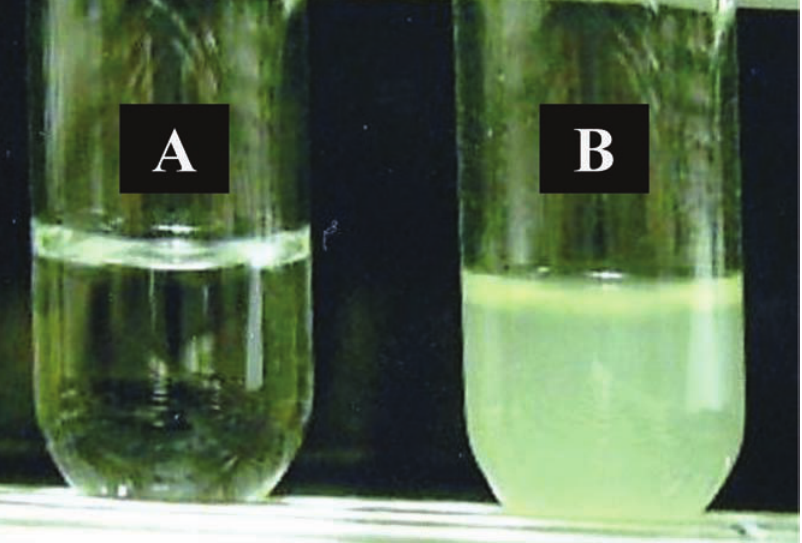
Figure 2. A photograph of the white turbid urine excreted after 13 days of ceftriaxone therapy. The urinary crystalline precipitates shown were confirmed to be ceftriaxone-cal- cium precipitates. The subject’s serum calcium level was normal (9.6 mg/dL), while his urinary calcium to creatinine ratio was high at 0.97 (normal for age: 0.60 3 ). A, distilled water for contrast; B, patient’s